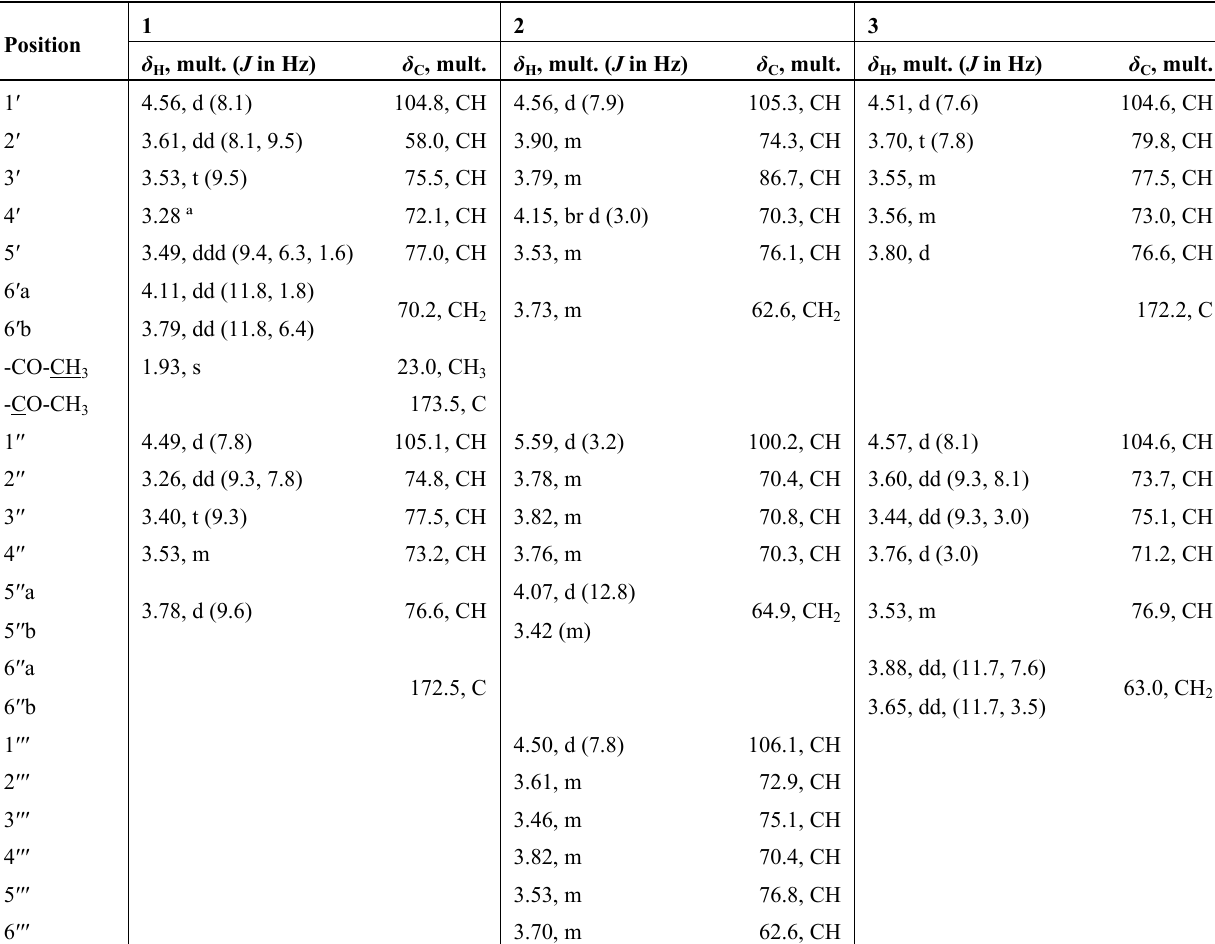
Table 2. 1 H (500 MHz) and 13 C-NMR (125 MHz) data for the sugars of 1 , 2 , and 3 (in CD